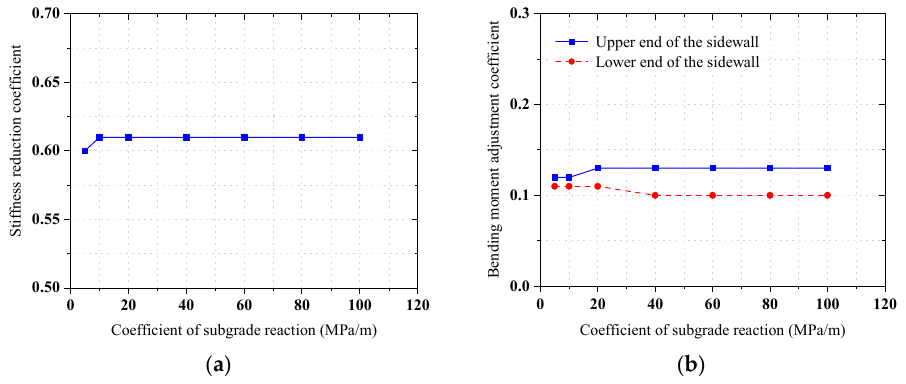
Figure 7. Influence of coefficient of subgrade reaction: ( a ) stiffness reduction coefficient and ( b ) bending moment adjustment coefficient.